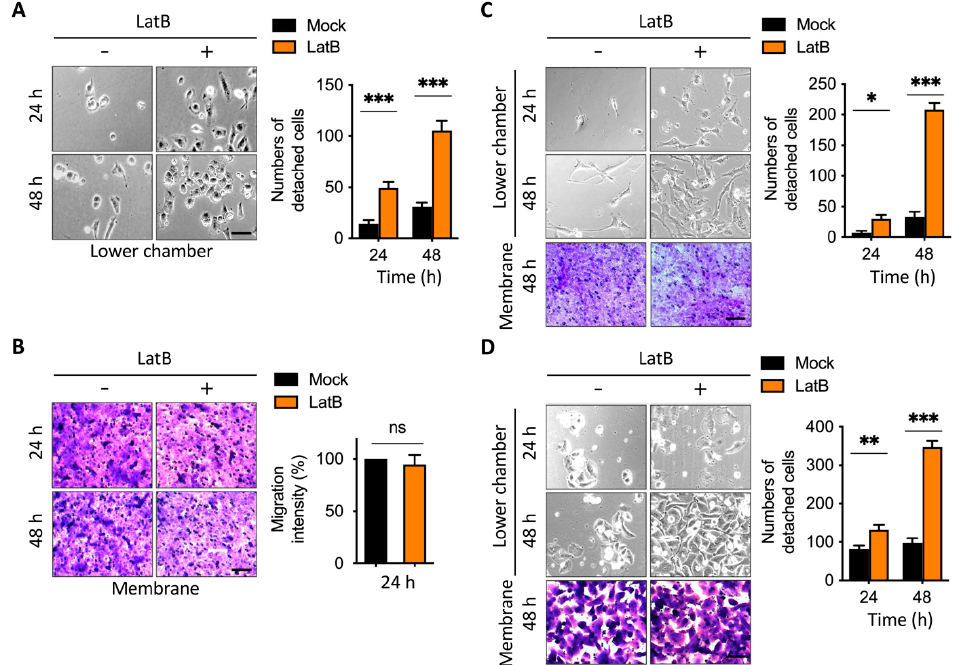
Figure 4. Latrunculin B disrupted autocrine TGF- β 1-induced transmembrane anchoring. ( A,B ) Images from the repre- sentative 2.5D detachment assay; A549 cells were seeded in the upper chamber overnight and the transwell assay was performed with or without serum in the upper chamber for 24 and 48 h. The membranes were stained by crystal violet and the cell number from the membranes or lower chamber was measured. Scale bars: 100 μ m. *, p < 0.05; ***, p < 0.001. Data are means ± s.d. (two-way ANOVA with Tukey’s multiple comparisons test and two-tailed t-test, A and B, respec- tively) from experiments with three replicates ( n = 3). ( C,D ) Addition of latrunculin B enhanced the leading cells detach- ment in BFTC909 and PANC-1. Scale bars: 100 μ m. *, p < 0.05; **, p < 0.01; ***, p < 0.001. Data are means ± s.d. (two-way ANOVA with Tukey’s multiple comparisons test) from experiments with three replicates ( n = 3).